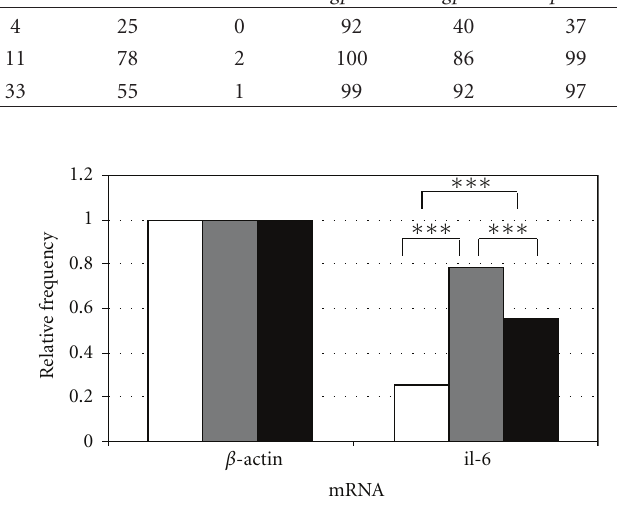
Figure 3: Quantitative analysis of mRNA expression of il-6 of single murine blastocyst either cultured in vivo (white) or in vitro in COOK’s Cleavage medium (grey) or in Vitrolife’s G-1 PLUS medium (black) compared to β -actin as housekeeping gene with ∗ P < 0 . 05; ∗∗ P < 0 . 02; ∗∗∗ P < 0 . 01. ART is influencing the gene expression [9–14].